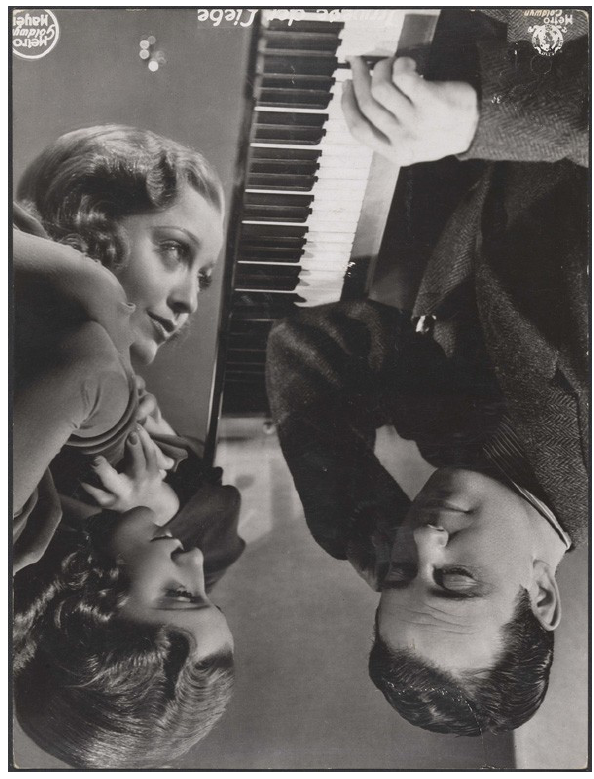
Figure 2: John Stezaker: Untitled, appropriated film still photograph,